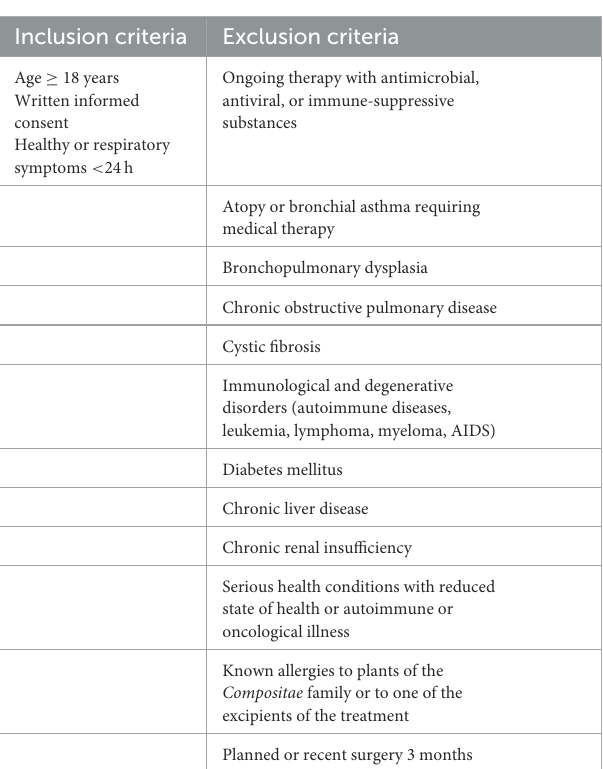
TABLE 1 Inclusion and exclusion